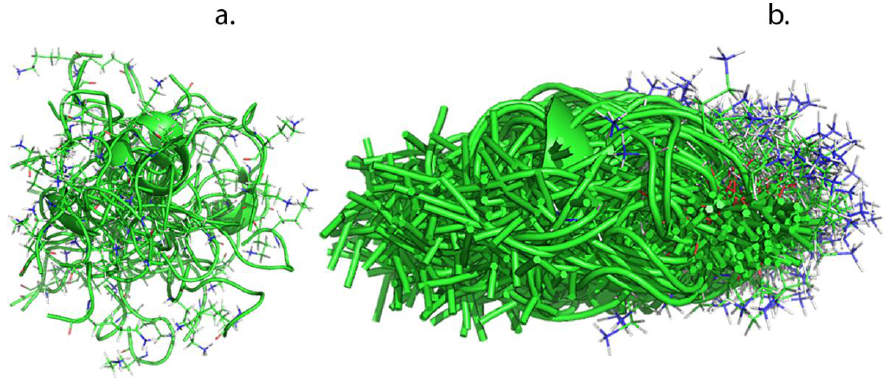
Figure 4. Hierarchical clusters of peptide simulations in water. ( a ) AGKT and ( b ) GGG SGA GKT. The backbone is shown in green and the lysine side chain is marked in stick representation. The illustrations show an ensemble of the same peptides in the many different structural conformations they can exhibit.